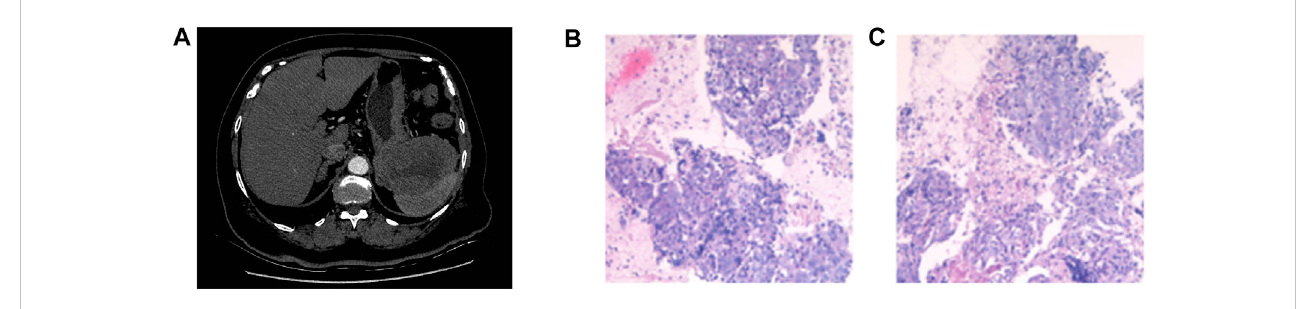
FIGURE 1 CT scan on 31 May 2019 revealed multiple masses in the gastrosplenic recess, the inferior capsule border of the spleen, and the right peritoneum (A) . Pathology results revealed poorly differentiated metastatic adenocarcinoma (B, C)